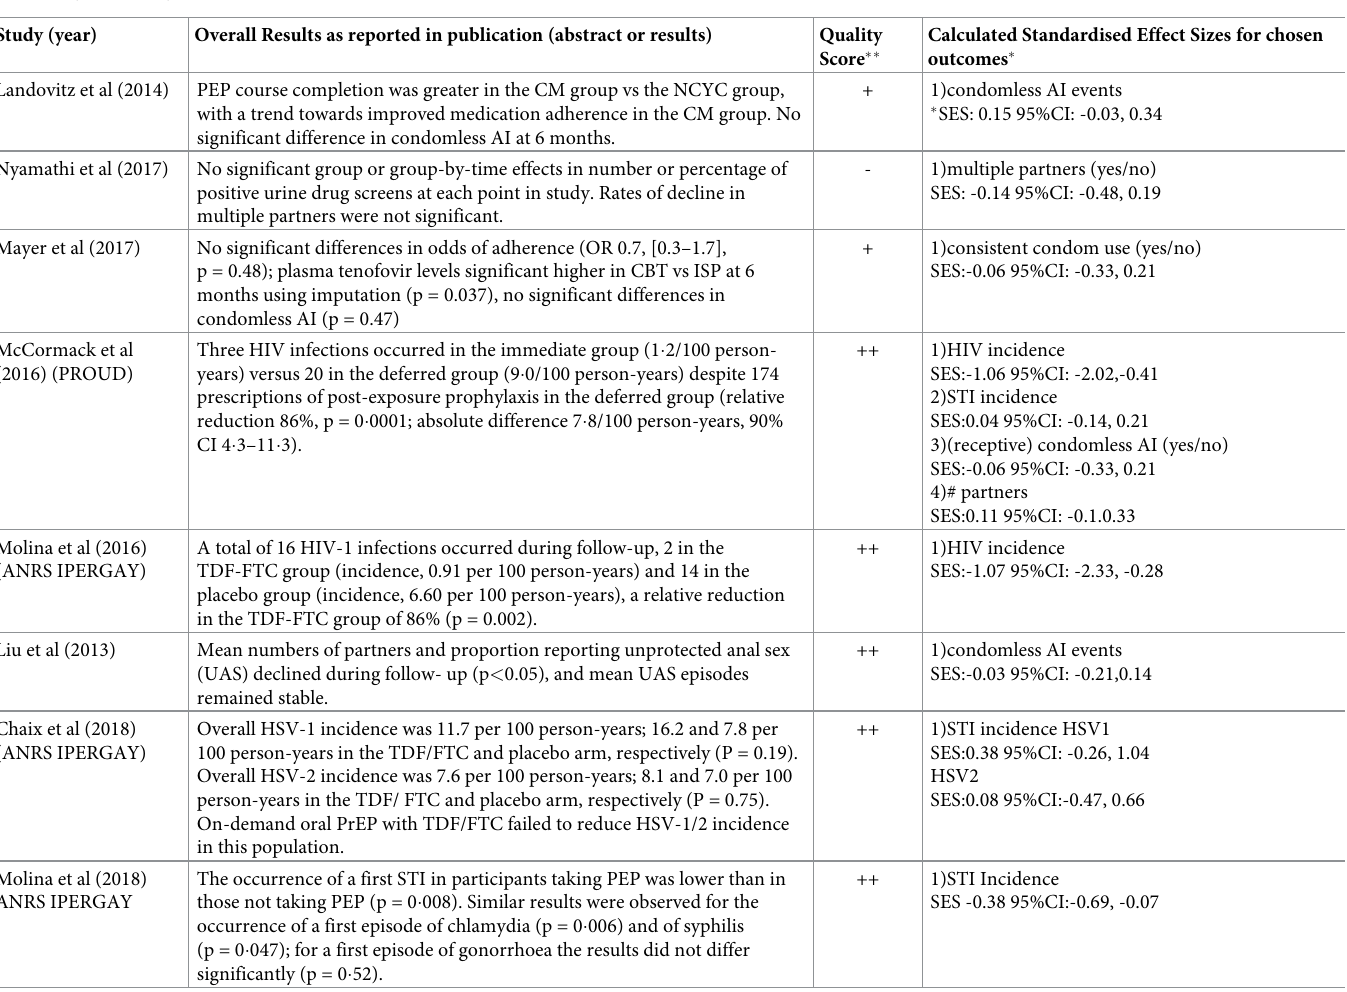
Overall Results as reported in publication (abstract or results) Quality